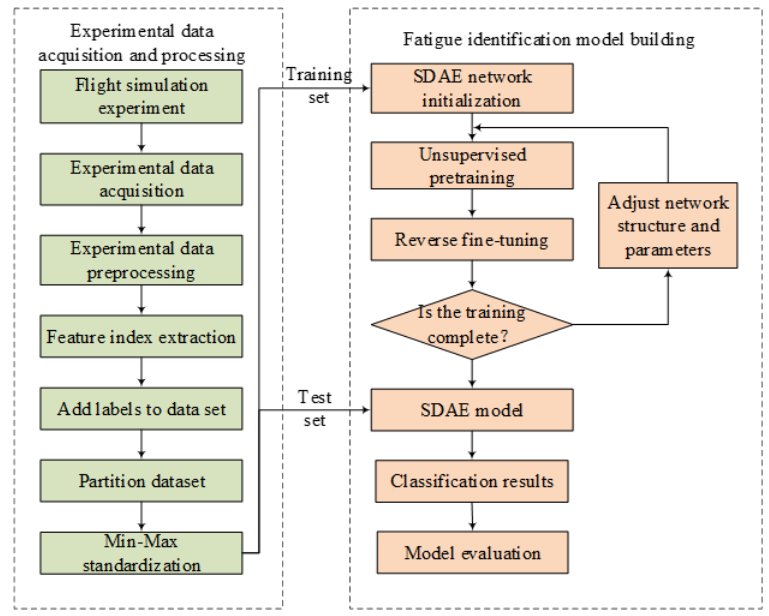
Figure 1. Research architecture diagram.